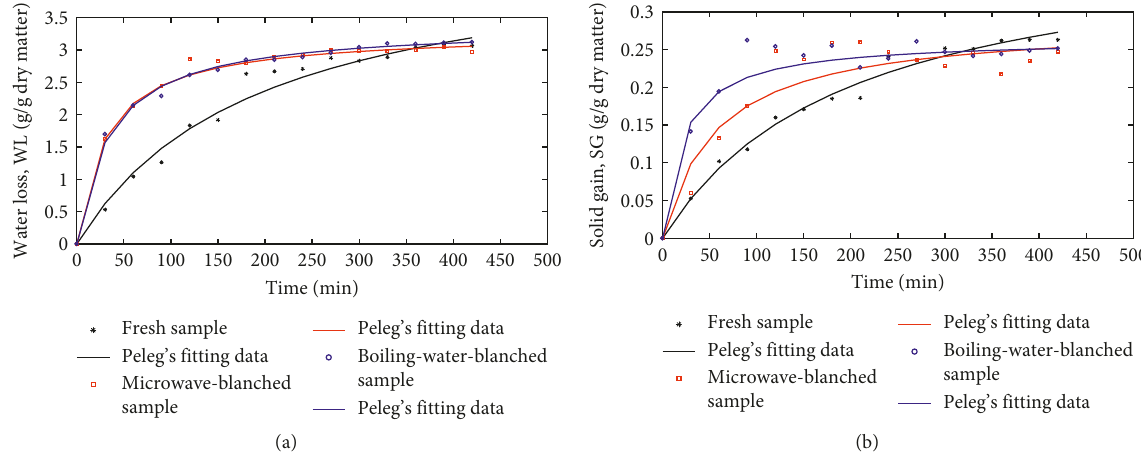
Figure 5: Effect of blanching pretreatment on the (a) water loss and (b) solid gain during OD of pomegranate seeds ( C 440rpm, and sample/solution weight ratio